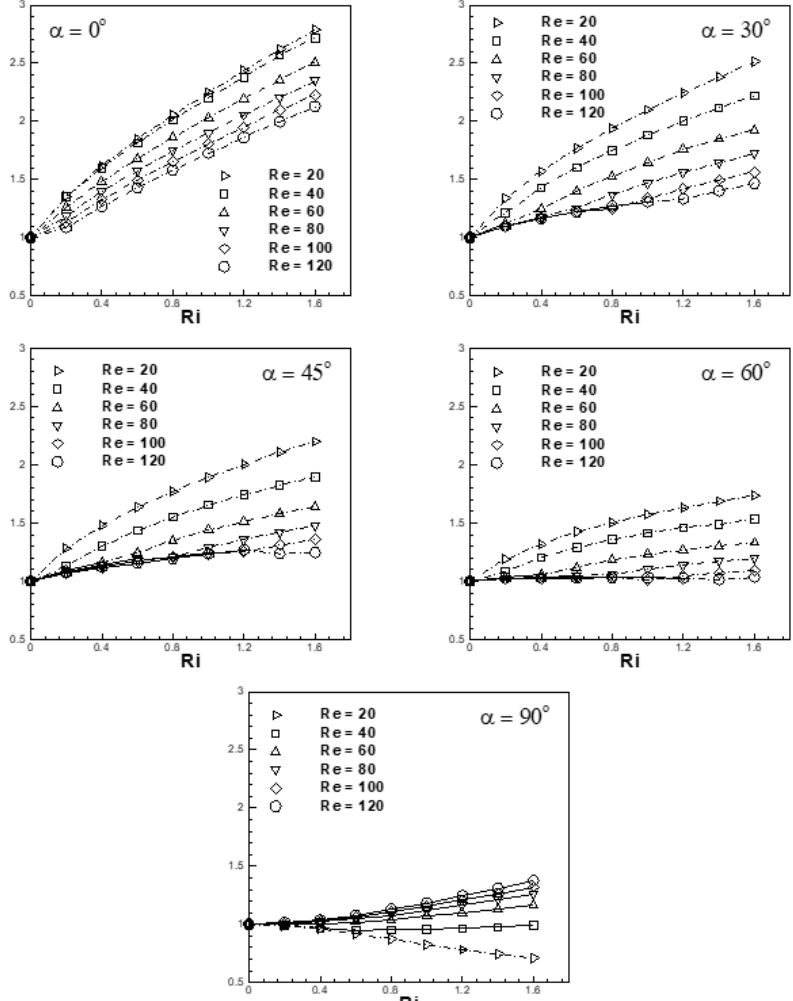
N u / ( N u ) = ) as a function of Richardson